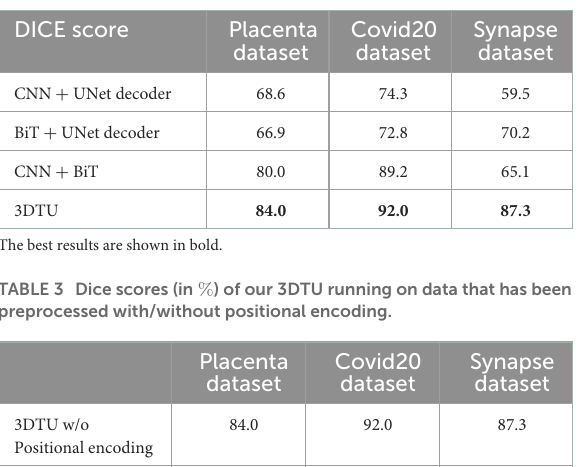
TABLE 2 Dice scores (in % ) of our 3DTU on three datasets. DICE score